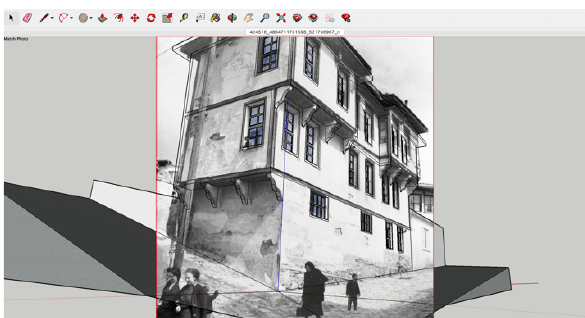
Figure 5. Virtual reconstruction of residential building using Image Based Modeling – Thessaloniki